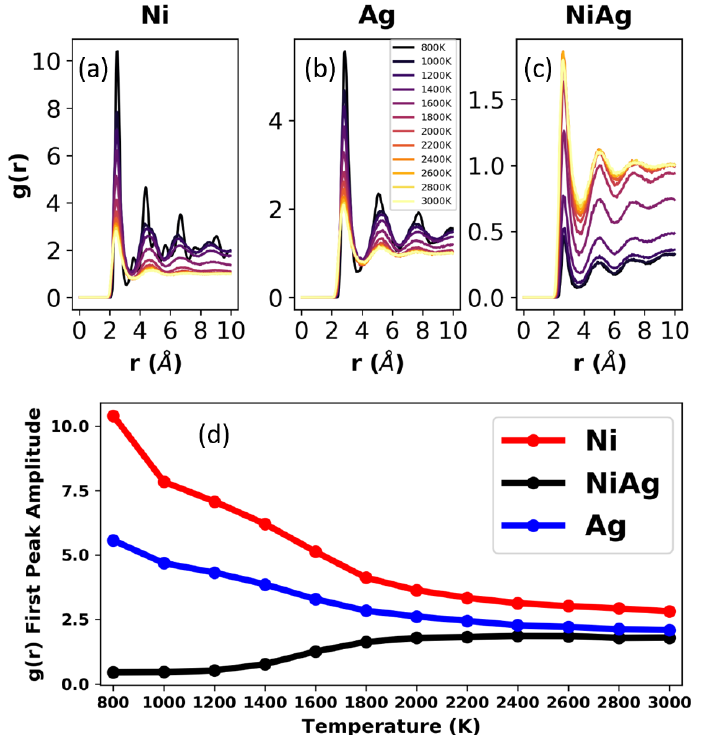
Figure 4. Radial distribution functions (RDFs) for the bulk samples at all the temperatures studied for Ni ( a ), Ag ( b ), and NiAg ( c ). ( d ) Plot of the the amplitude of the first peak (located between radii of 2 and 3 angstroms), as a function of temperature for Ni, Ag, and NiAg.